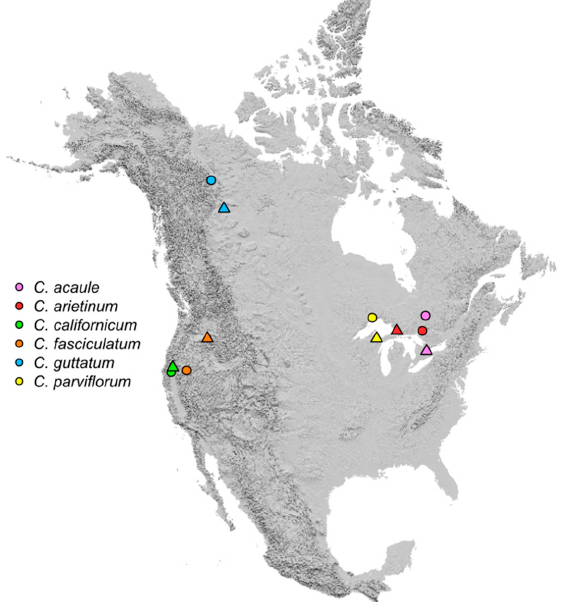
Figure 1. Map showing directional shifts of suitable habitat centroids for six Cypripedium species in North America between the ETI and LTI. Colors represent species, circles represent ETI centroids, and triangles represent LTI centroids.